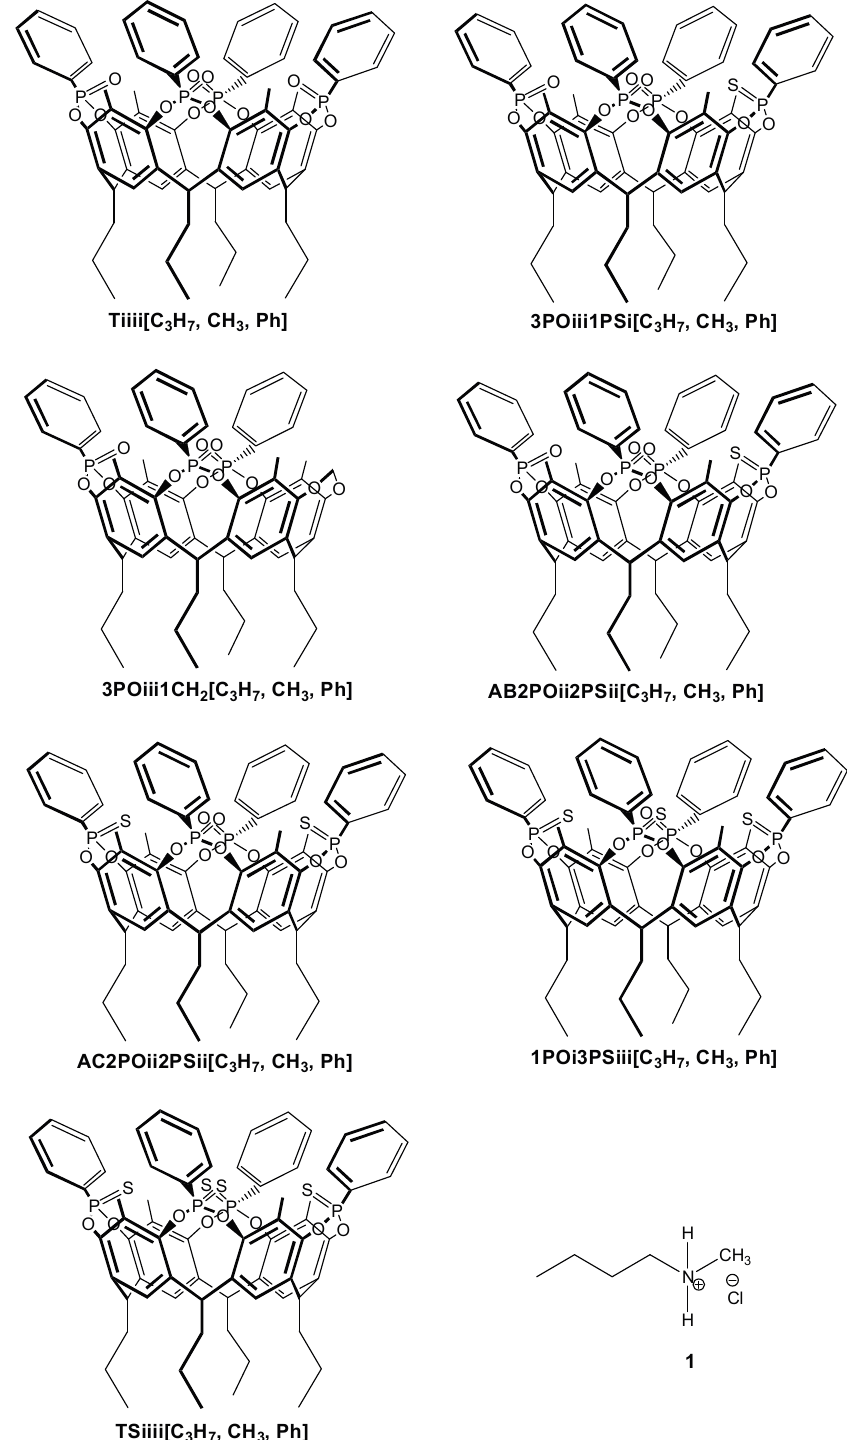
Figure 1. Molecular structures of cavitands and of the guest used in the present